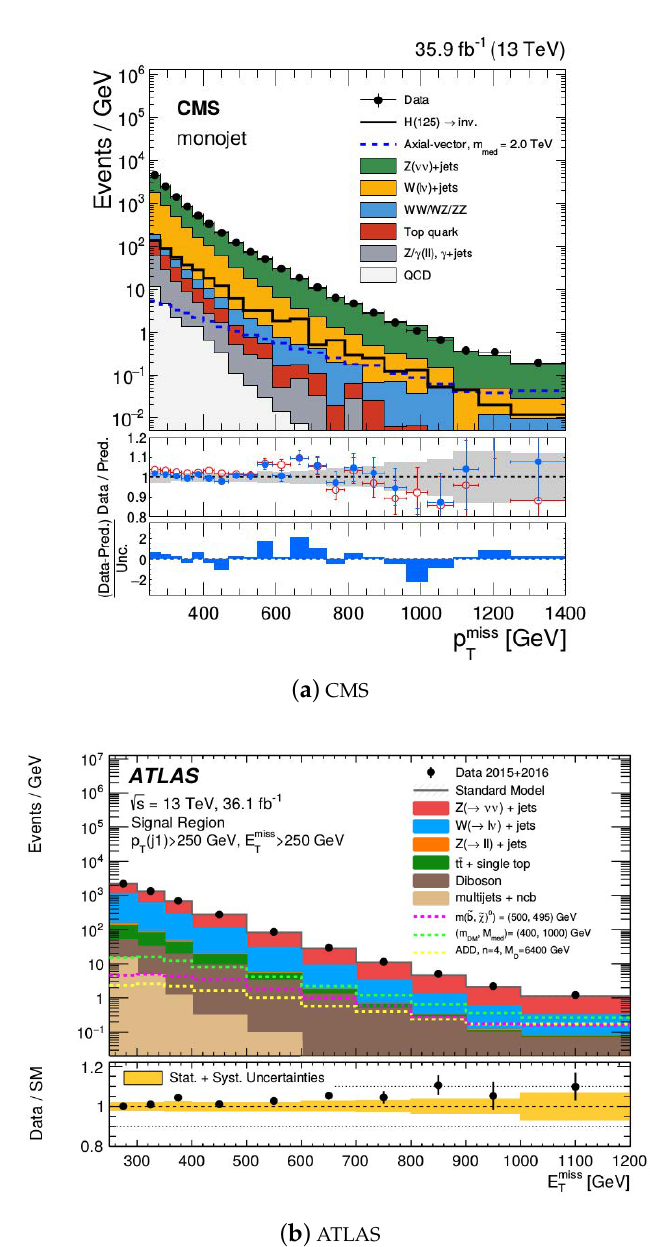
Figure 2. Data-Montecarlo (MC) distributions of the mono-jet signal regions for the CMS [7] ( a ) and ATLAS [8] ( b )